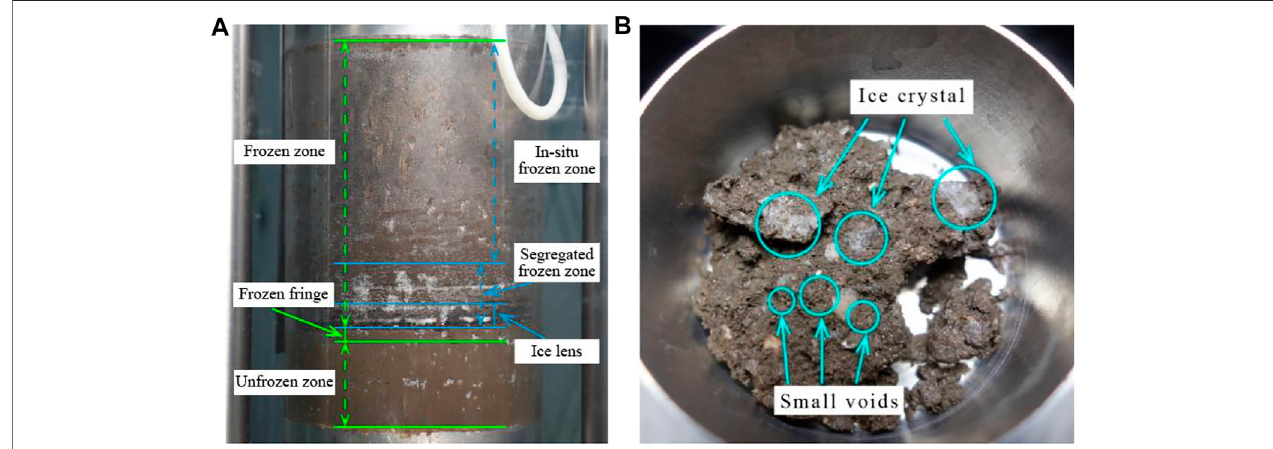
FIGURE 9 | Freezing results of CGS sample. (A) Variations of soil temperature and change rate of temperature; (B) variations of frost heave and water intake.